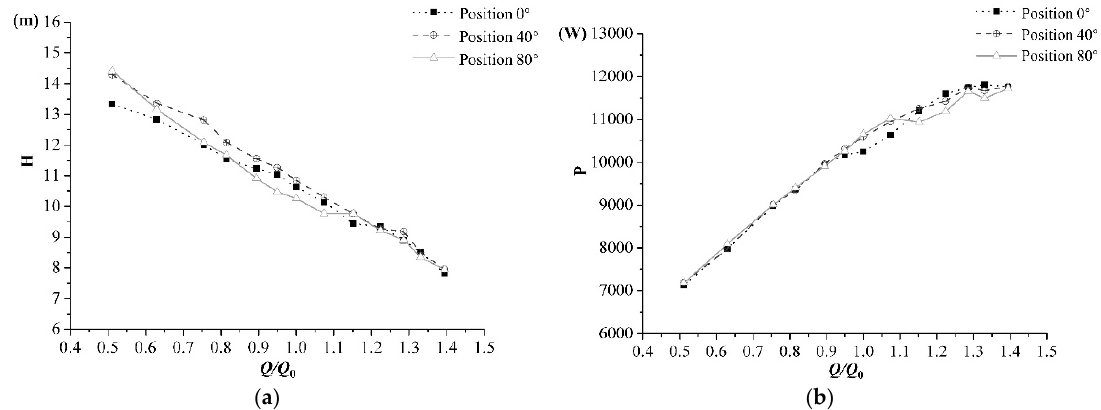
Figure 5. The influence of clocking positions on the head and power at different operating conditions—( a ) head; and ( b ) power.